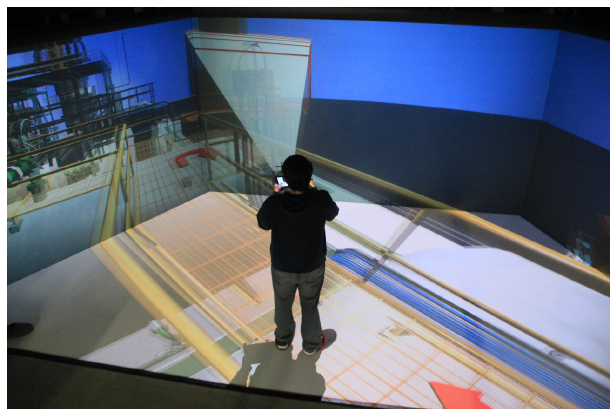
Figure 11. Testing the frustum.